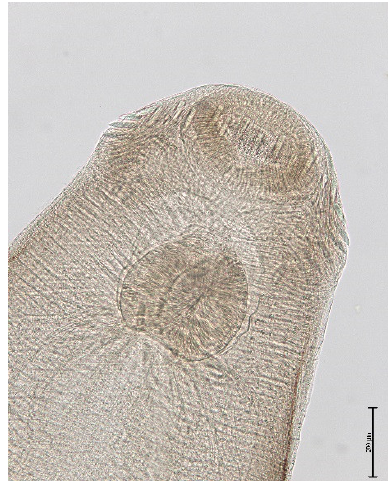
Figure 2. Echinostoma sp., anterior end with armed head collar, oral sucker and pharyx. Bar: 200 μm.